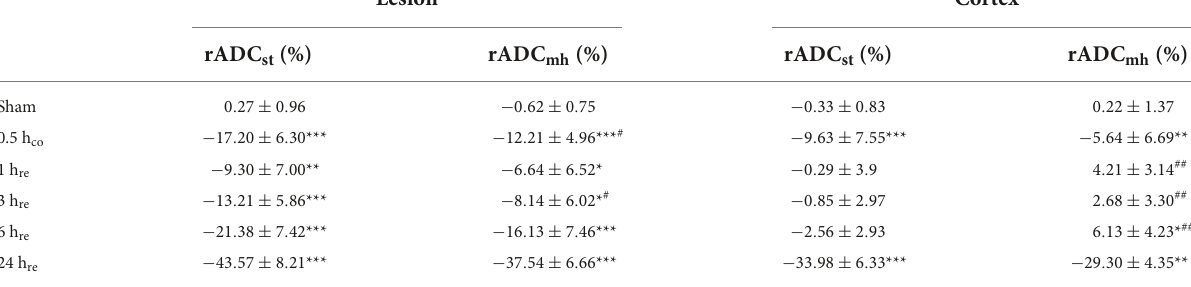
ADC was then calculated. Mean rADC values of standard and multi-high b -values at different time points are summarized in Table 2 . Compared with the sham group, both the rADC st and rADC mh of the lesion in the ischemia group were statistically different at each time points. However, at each time point, the ADC mh value was higher than that of ADC st , and there were statistical differences between them at 0.5 h co and 3 h re time points ( p < 0.05). In the cortex, the small value were detected on both ADC st and ADC mh maps at 0.5 h co and 24 h re time points, which were much lower than the sham group ( p < 0.001). From 1 to 6 h after MACO, we detected an increased ADC mh values in cortical regions, the relative change was much higher than that of ADC st ( p < 0.01). Whereas compared to the sham group, there were statistically different only at 6 h re time point.